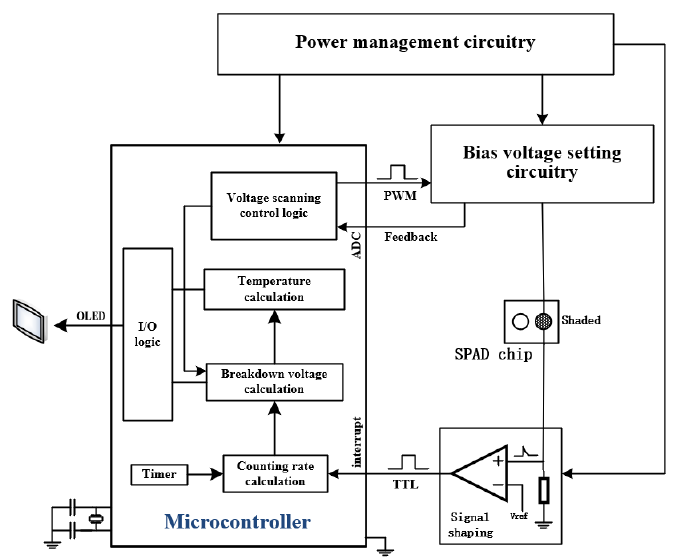
Figure 1. Block diagram of the proposed system.